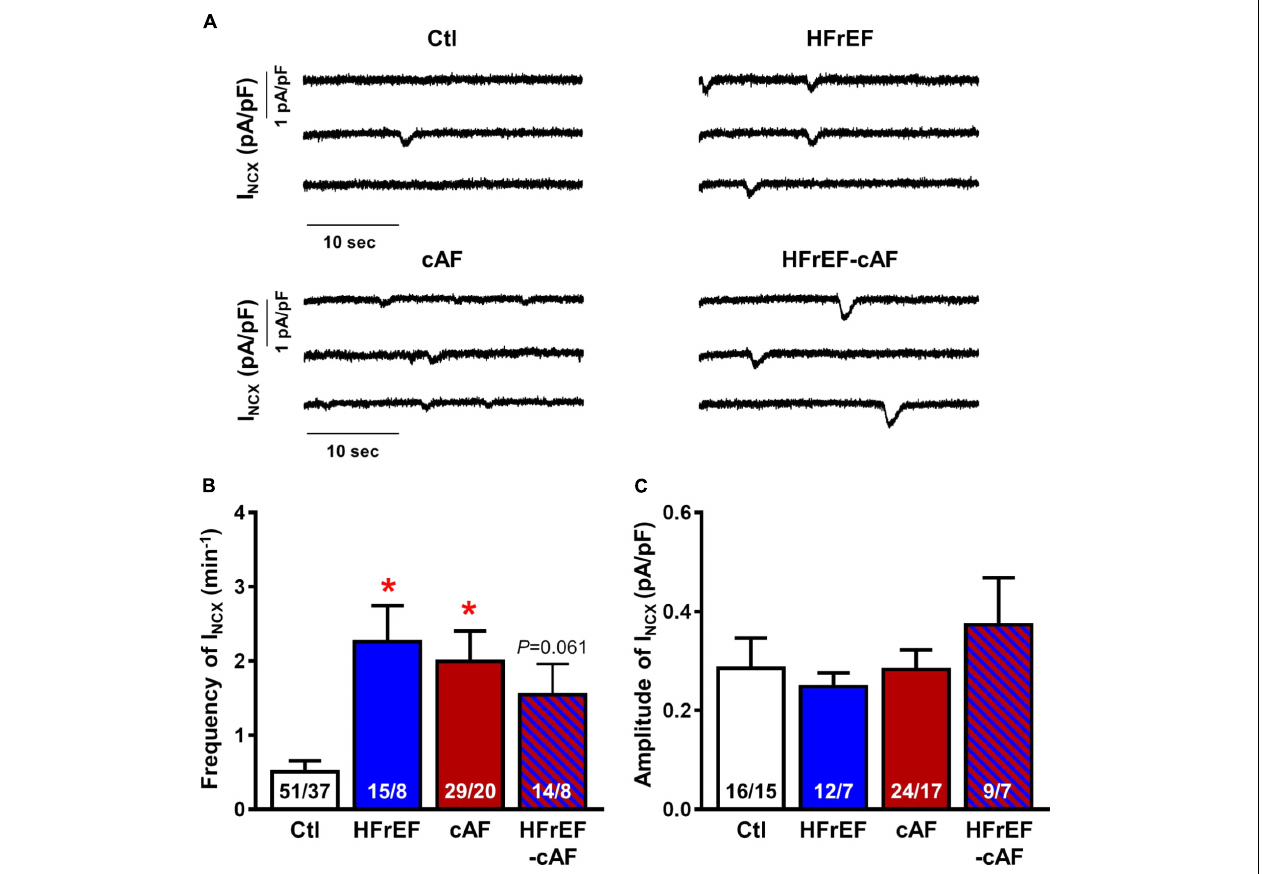
FIGURE 4 | Spontaneous Ca 2 + -release events in isolated human atrial cardiomyocytes. (A) Representative recordings of NCX-mediated transient-inward current (I NCX ) in atrial cardiomyocytes from Ctl, HFrEF, cAF or HFrEF-cAF patients. (B,C) Frequency (B) and amplitude (C) of spontaneous I NCX in the four groups. Numbers in bars indicate number of cells/number of patients. ∗ indicates P < 0.05 vs.